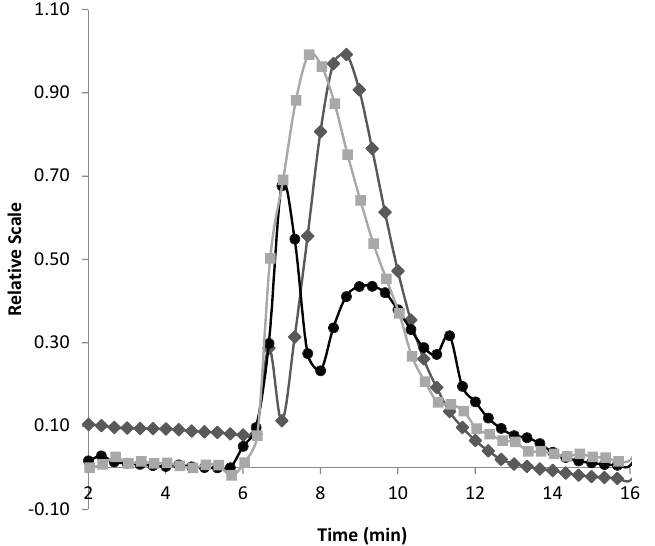
Figure 3. Fractogram of EPS-DRS (squares: UV-VIS @ λ = 254 nm; circles: dRI; diamonds:MALS @ 90°). [EPS-DRS] = 2 mg mL − 1 ; injection volume = 20 µL; eluent = MilliQ water with 0.1% in volume of Tween 20; membrane = PES 5 kDa; canal length = 291 mm; spacer = 350 µ m; cross flow = from 2 to 0 mL min − 1 in 17 min; injection flow = 0.20 mL min − 1 ; focalization flow = 2 mL min − 1 ; detector flow = 1 mL min − 1 .